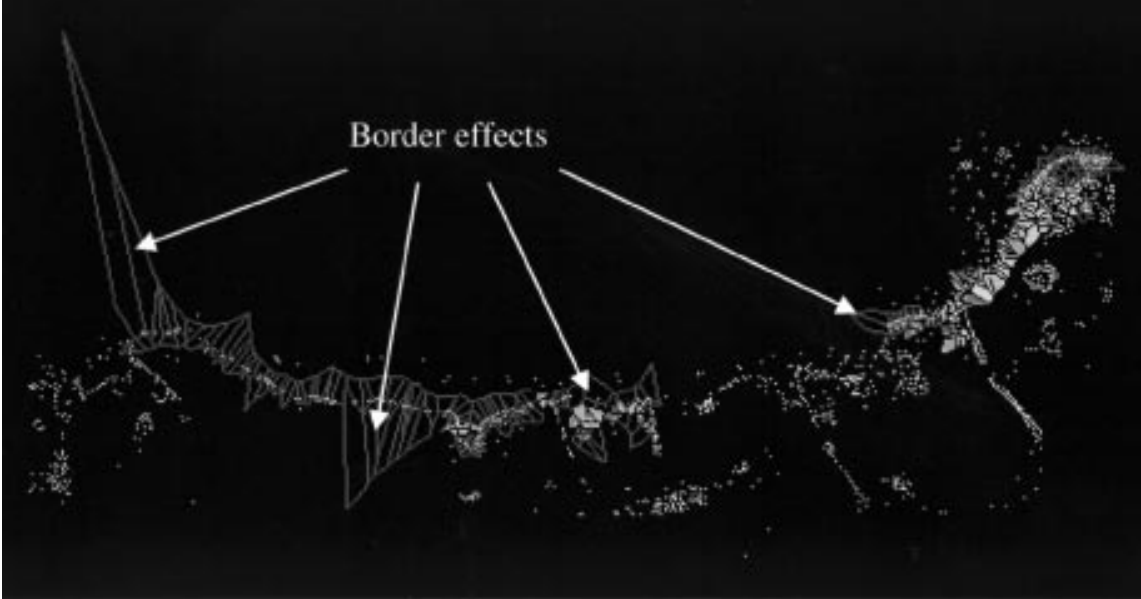
Fig. 8. A 2D swarm of pointlike seeds, generated from oral squamous cell epithelium. Several areas for analysis have been cut out digitally. Any polygon that could be modified by making the area of interest slightly larger (i.e., include additional number of seed peripheral to the considered swarm of points) are considered as border polygons. Border effects in the peripheral Voronoi polygons (arrows) are obvious. Scale bar 0.25